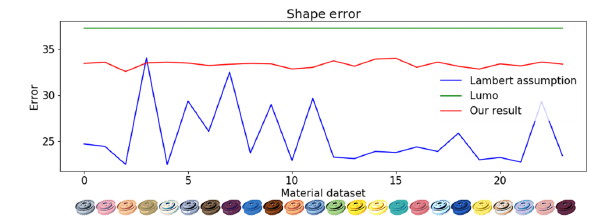
Fig. 15 Errors of estimated shape depending on input material (complex shape Pulley